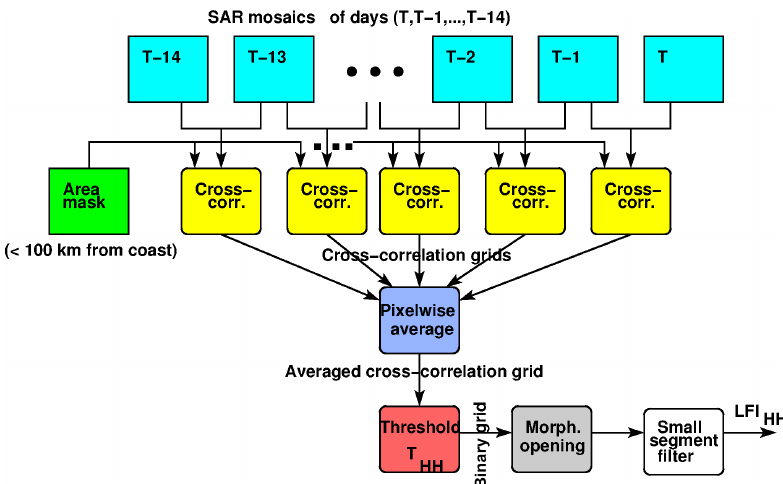
Figure 3. Block diagram of the LFI detection (FMI-A) for Sentinel-1 HH polarization channel. The process for the HV channel is similar, except that a threshold value of T HV is applied instead of T HH .